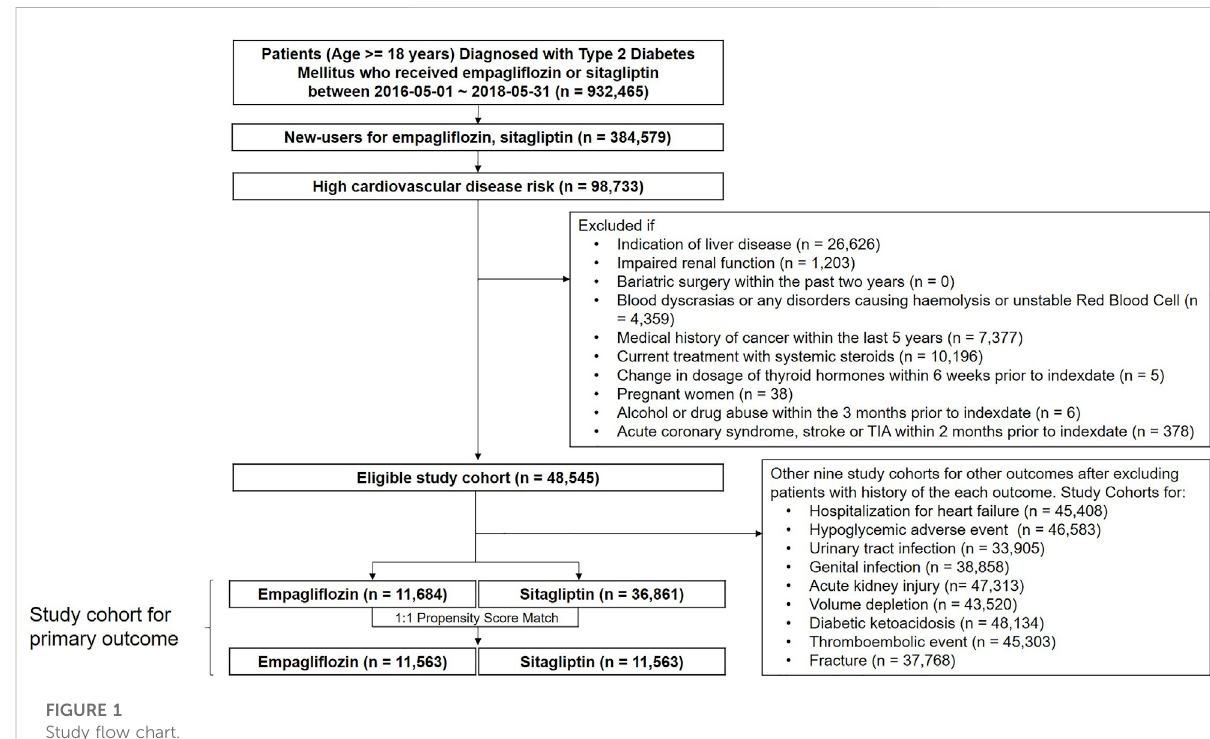
FIGURE 1 Study fl ow